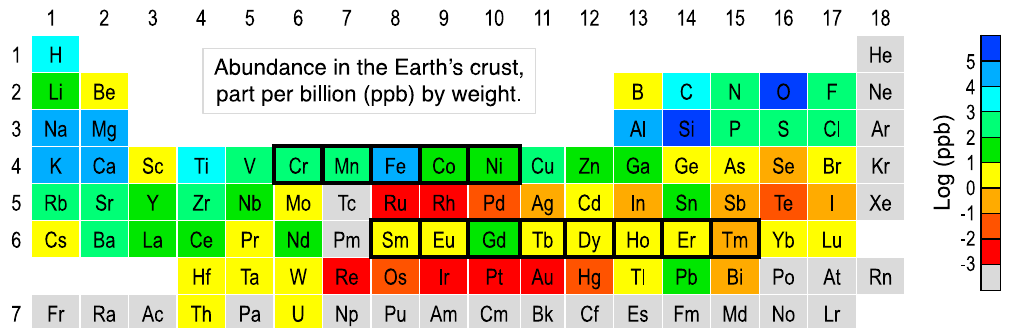
Figure 1. Periodic Table with abundances of chemical elements in solids of the Earth’s upper crust. Marked are the most magnetic elements (atoms or ions in neutral or partially oxidized states).